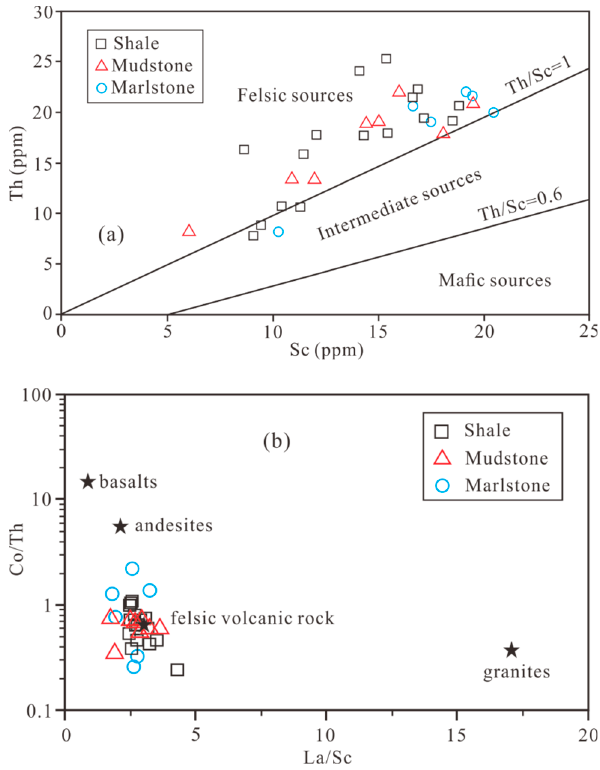
Figure 9. Source and compositional discrimination diagrams of ( a ) Sc vs. Th and ( b ) La/Sc vs. Co/Th for the black rock series from Zhenning section. Base map modified from [50]. Minerals 2018 , 8 , x FOR PEER REVIEW